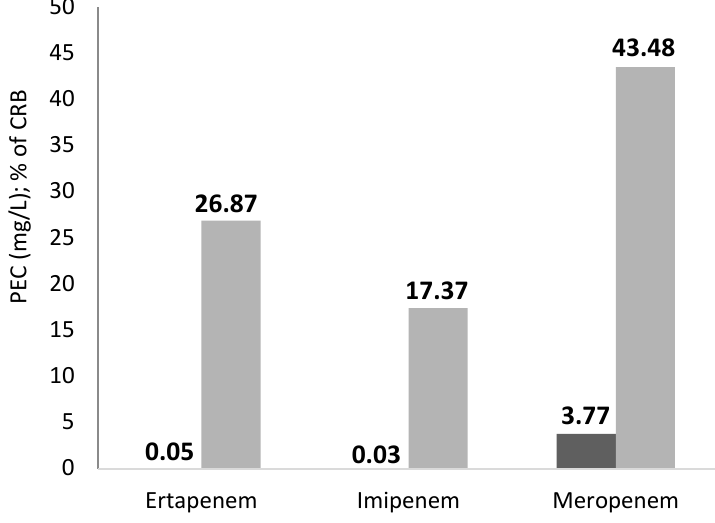
Figure 1. Graphical representation of the Predicted Environmental Concentration ( ■ ) (in mg/L): in comparison with the percentage of Carbapenem-resistant bacteria ( ■ ) (in %) in ArzH. Figure 2 present the seasonal variation of antibiotic resistance AMR in hospital ef- fluent Ar-razi Hospital. The AMR in hospital effluent bacteria for carbapenems and also the 21 other ABs studied varies according to the seasons, indeed it is maximum in winter (84.11%) for the 21ABs and (77.78%) for carbapenems, and during the other seasons the percentage of AMR does not exceed 62% as the maximum value and is detected for the 21 ABs and decreases to 12.70% and is detected for the carbapenems. Figure 2. Seasonal variation of antibiotic resistance AMR in Ar-razi Hospital effluent. When a hospital is involved, as in our situation, the Defined Daily Dosage per 1000 beds (DDD/1000 beds) or per 1000 inhabitants (DDD/1000 inhabitants) is typically used to calculate drug consumption. The consumption of the most popular antibiotic families in ArzH from 2016 to 2019 is shown in Table 2.